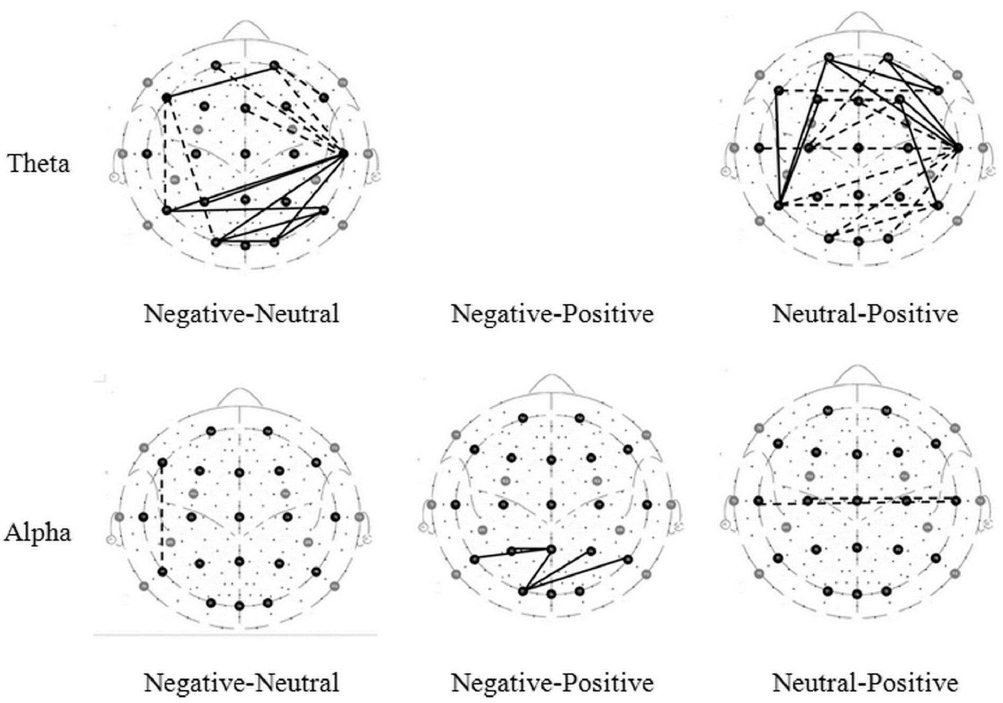
Figure 1. Brain maps of correlation. The lines connecting electrode sites indicate significant higher (solid) and lower (dashed) of correlation values for condition listed on left site.